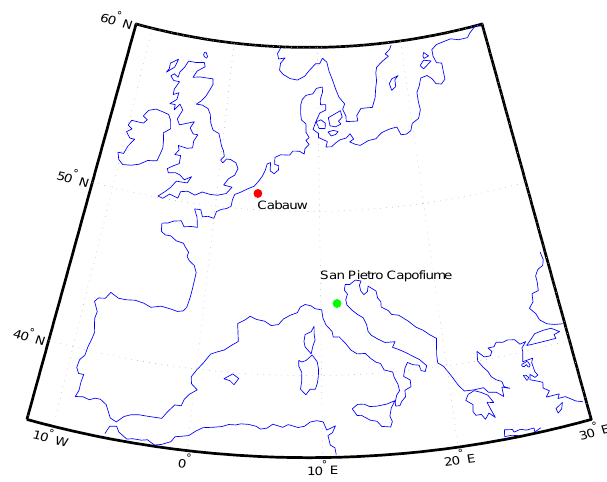
Figure 1. Map showing the different measurement sites in Europe: Cabauw located in the Netherlands (red dot) and San Pietro Capofi- ume (green dot) located in the Po Valley in